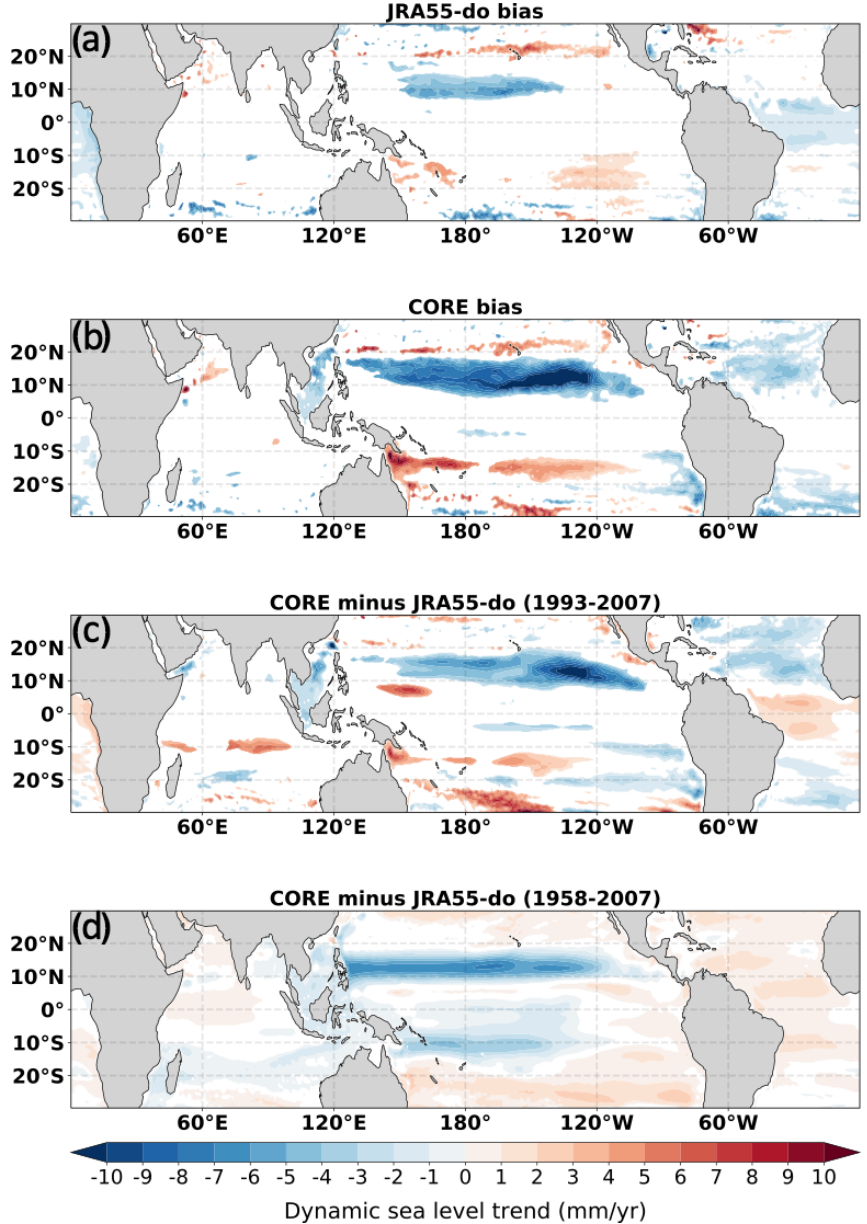
Figure 9. The DSL trend bias (CMEMS-derived DSL subtracted from the simulations) during the 1993–2007 period common to CORE and JRA55-do. Panel (a) shows the JRA55-do-forced simulation. Panel (b) shows the CORE-forced simulation. DSL trend difference is determined by subtracting JRA55-do from CORE during 1993–2007 in panel (c) and during 1958–2007 in panel (d) . The shaded colors show the trend biases or differences that are statistically significant with 99%